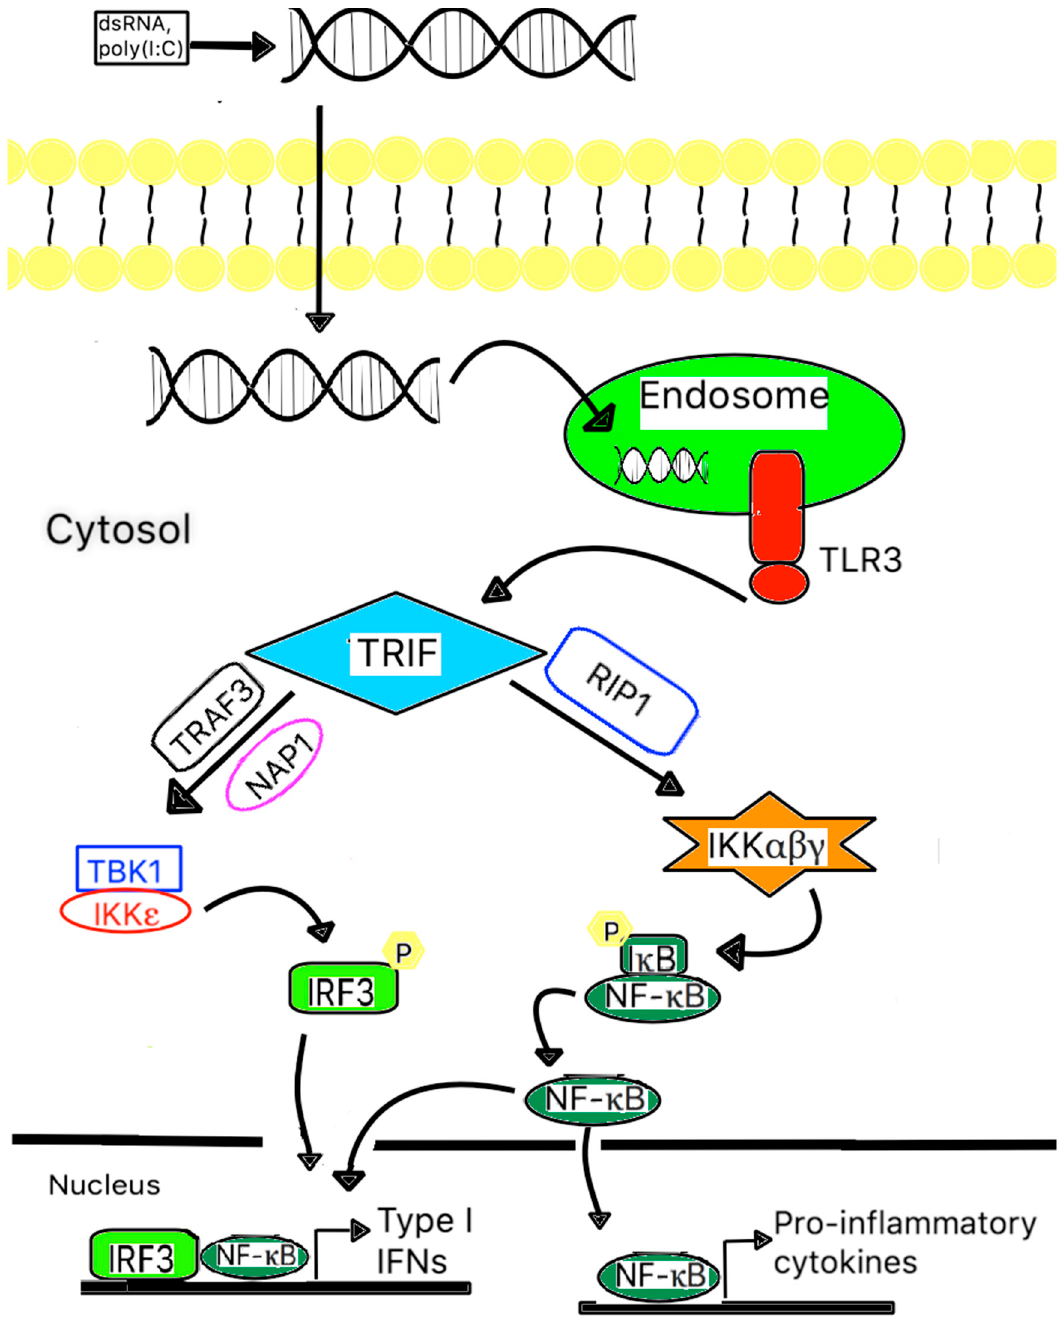
Figure 1. A scheme of TLR signaling pathways related to mycobacterial recognition. TLR3 is expressed on the endosomal membrane of cells. Uptake of either extracellular dsRNA or poly (I:C) into the cells and subsequent binding to TLR3 leads to the dimerization of TLR3, followed by recruitment of the adaptor protein TICAM-1 / TRIF via a transient association with the TIR domain of TLR3. Subsequently, TICAM-1 / TRIF will form a complex with RIP1, where it activates IKK and results in the activation of NF-B. TICAM-1 / TRIF also forms a complex with TRAF3 and NAP1, where they recruit and activate TBK1 and IKK, resulting in the phosphorylation of IRF3. Both activated NF-kB and phosphorylated IRF3 are translocated into the nucleus and induce type I IFNs and other pro-inflammatory cytokine gene expression.